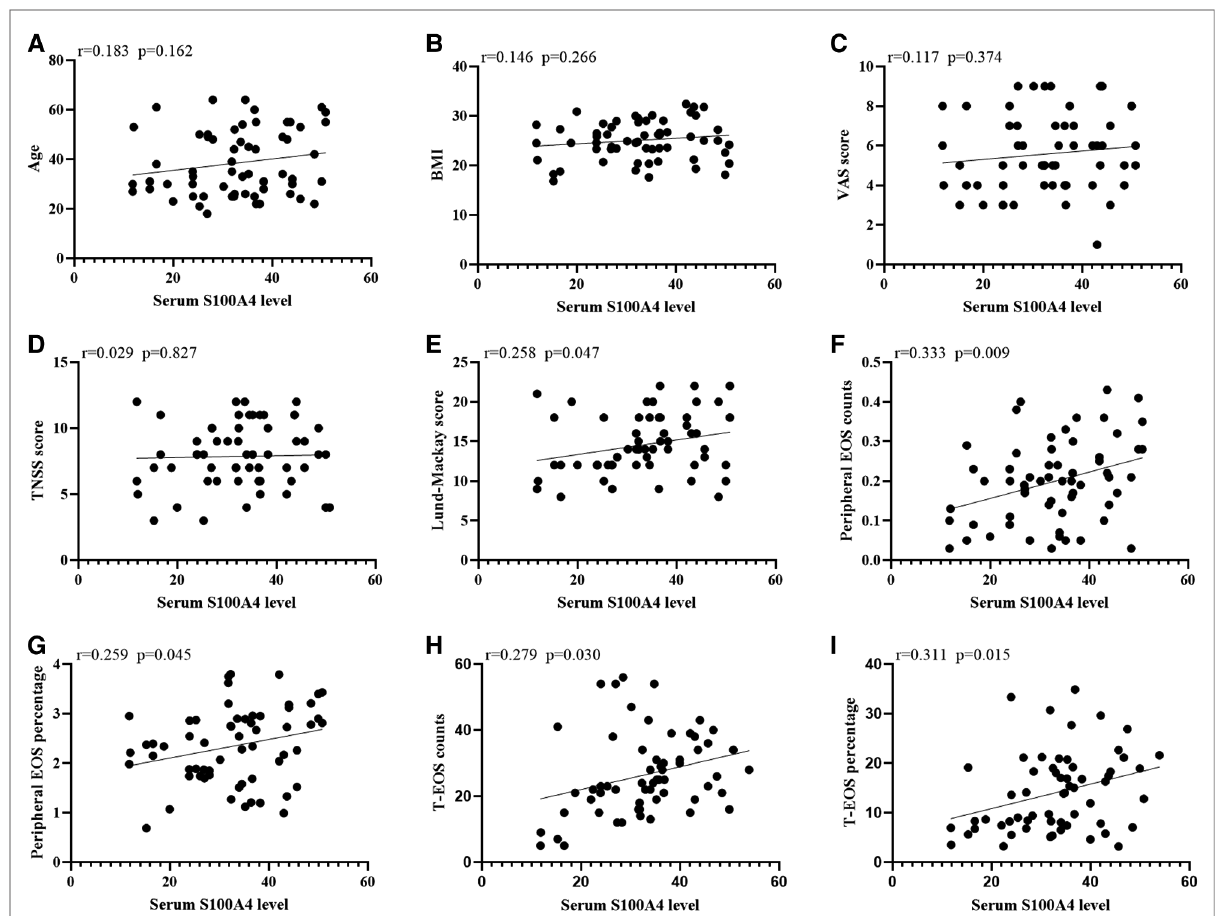
FIGURE 2 The associations between serum S100A4 levels and clinical variables ( A-I ) in CRSwNP patients. Elevated serum S100A4 mRNA levels exhibited positively correlation with Lund-Mackay score, peripheral EOS count and percentage and T-EOS count and percentage ( E-I ). Abbreviations: CRSwNP, chronic rhinosinusitis with nasal polyps; BMI, body mass index; VAS, visual analog scale; TNSS, total nasal symptom scores; EOS, eosinophil; T-EOS, tissue eosinophil.